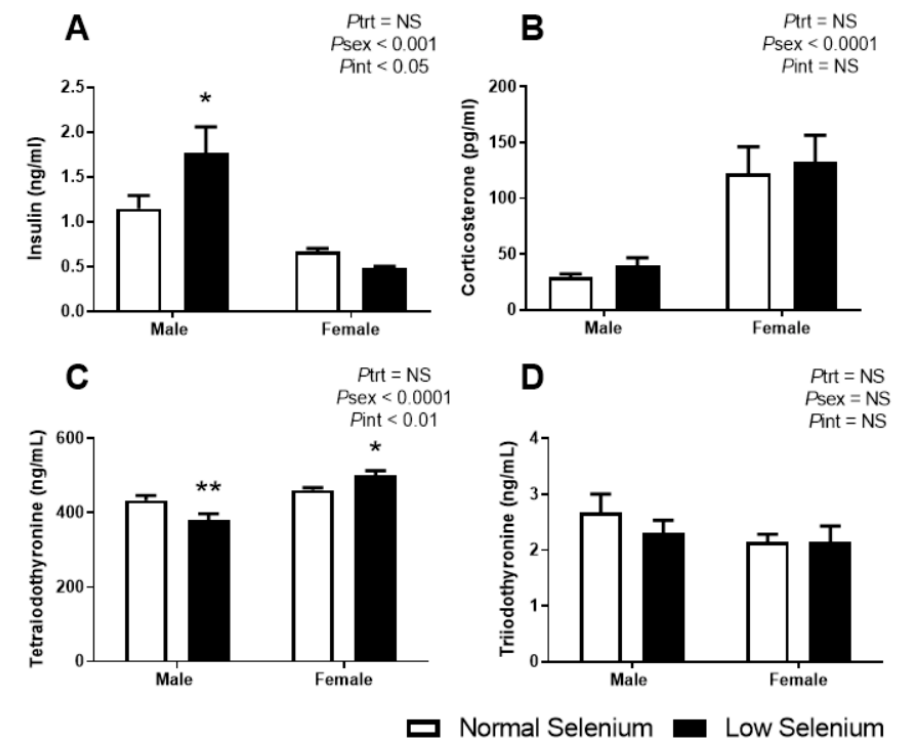
Figure 3. Offspring plasma hormone levels. PN180 plasma levels of ( A ) insulin, ( B ) corticosterone, ( C ) tetraiodothyronine (thyroxine) and ( D ) triiodothyronine. Open bars (white) indicate offspring from litters that consumed a normal selenium diet, whereas closed bars (black) are offspring from litters that consumed a low selenium diet throughout pregnancy and up until weaning. Data are mean ± SEM and analysed by two-way ANOVA with treatment ( P trt ) and sex ( P sex ) as major factors. P int represents the interaction between treatment and sex. Multiple comparisons were determined by Sidak posthoc testing. * = p < 0.05, ** = p < 0.01 compared to control of same sex. n = 6–9.